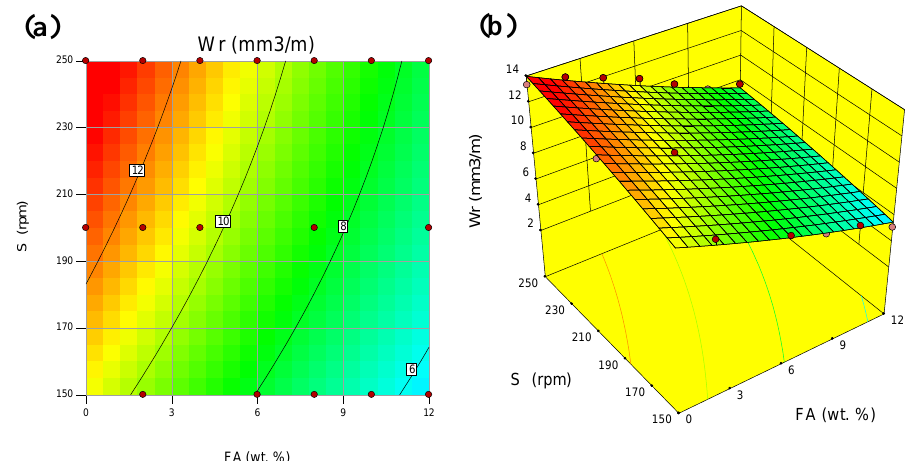
Figure 3. View of the interactive effect of FA and S on Wr, ( a ) contour lines 2D, ( b ) 3D. Design-Expert® Software Factor Coding: Actual wear rate (mm3/m) Design points above predicted value Design points below predicted value 13.3471